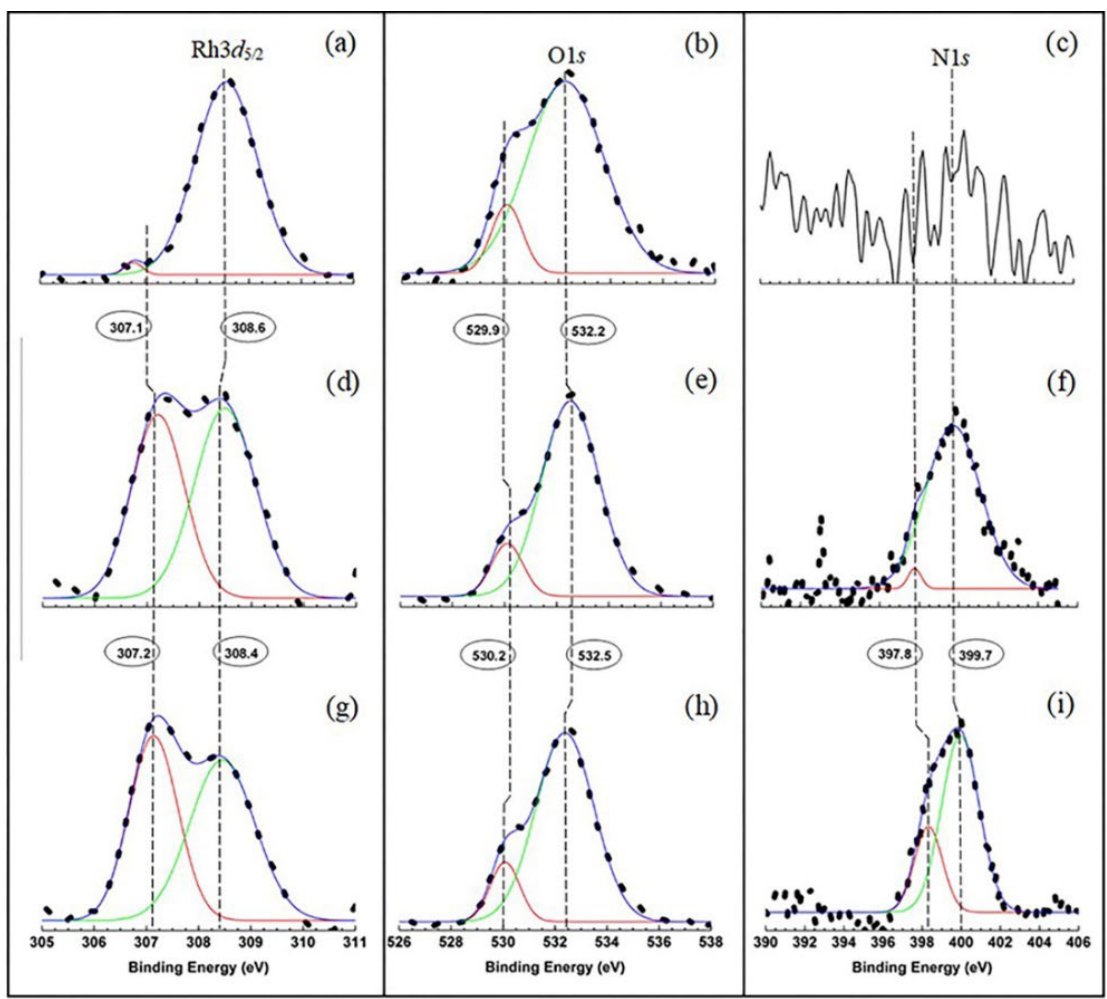
Figure 4. XPS spectra of Rh3 d 5/2 ( a , d , g ), O1 s ( b , e , h ) and N1 s ( c , f , i ) with the peaks separated by deconvolution of these spectra for the unused Pt–Pd–Rh–Ru gauze ( a – c ) and also for the back ( d – f ) and frontal ( g – i ) sides of such gauze after NH 3 oxidation. Data in Table 1 demonstrated an essential difference in the concentrations of detected elements. For all the gauzes, carbon and oxygen were detected in high concentrations equal to 57.9, 48.4 and 56.3 at.% for C and 29.8, 35.3 and 31.1 at.% for O, whereas the other elements had much lower concentrations ranging from 1.0 to 5.0 at.%. Thus, the XPS study detected Pt, Pd, Rh, C and O in a ca. 5 nm-thick surface layer on the new Pt–Pd–Rh–Ru gauze, whereas Pt, Pd, Rh, C, O, N and Si were observed on both sides (back and frontal) of the spent gauze. Two XPS peaks were revealed for Rh, C, O and N, which indicated different states of atoms for these elements. This suggests that on all the gauzes, the surface layer with a thickness of ca. 5 nm contained the metallic alloy of Pt 0 , Pd 0 and Rh 0 atoms, Rh 2 O 3 oxide, graphitic carbon and the adsorbed layer of OH ad and CO ad . The surface layer of the gauzes had high concentrations of carbon and oxygen (48.4–57.9 at.% for C and 29.8–35.3 at.% for O) and low concentrations of the other elements ( ≤ 5 at.%). The data obtained were used to elucidate the composition and structure of the surface films on the gauzes under